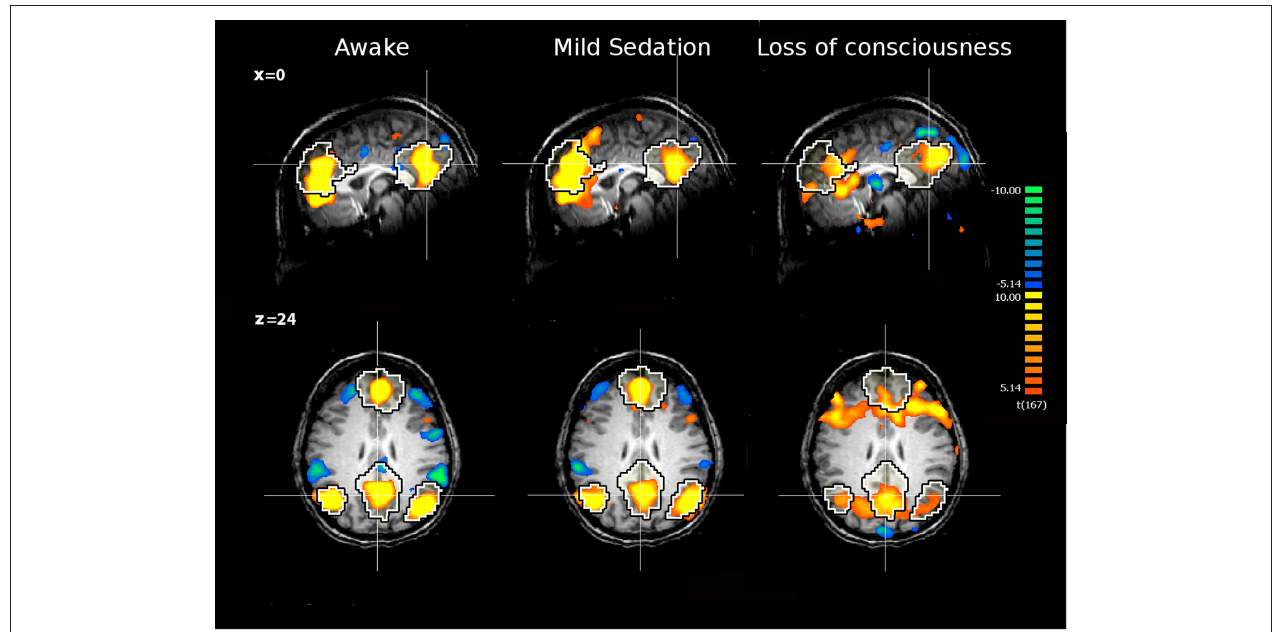
the time course of the internal network. The green and blue colors represent the areas which activities are anticorrelated with activities of the internal network, i.e., the external network. The anticorrelation disappears during deep sedation. The figure is based on data from Boveroux et al. (2010).